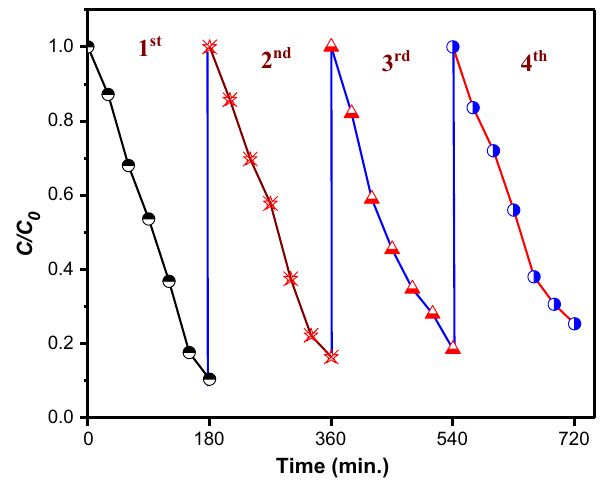
Fig. 11 Four repeated processes of 4% Zr-doped SnO degradation of MO under UV–visible-light irradiation